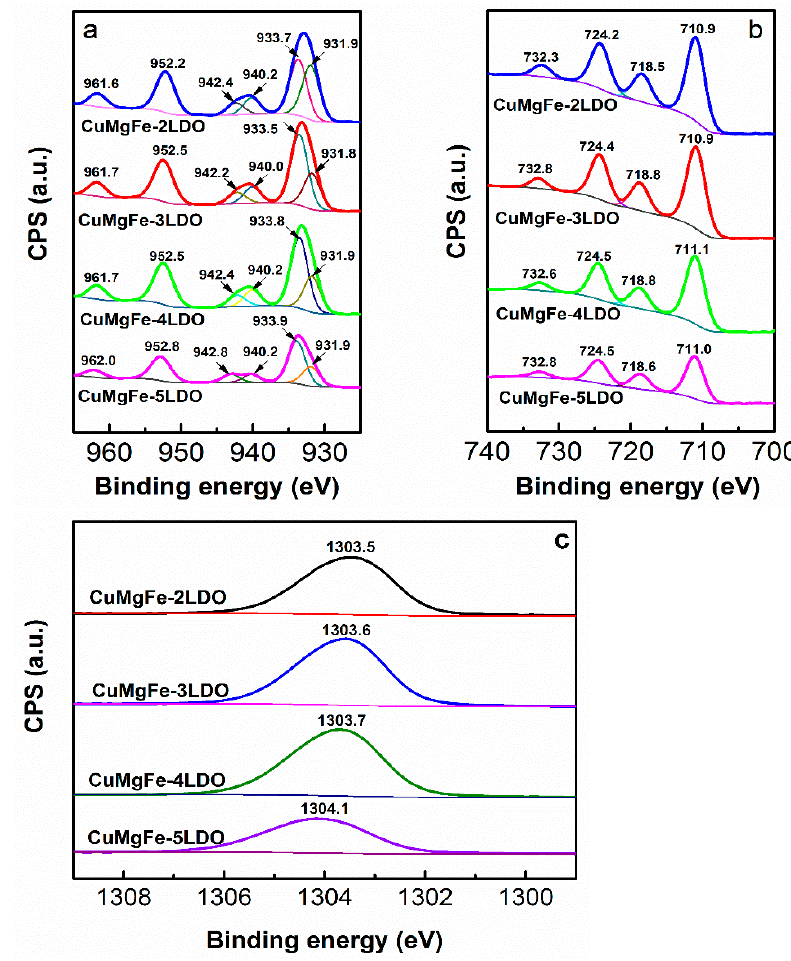
Figure 5. XPS spectra of ( a ) Cu 2p, ( b ) Fe 2p, and ( c ) Mg 1s of the CuMgFe-xLDO catalysts.